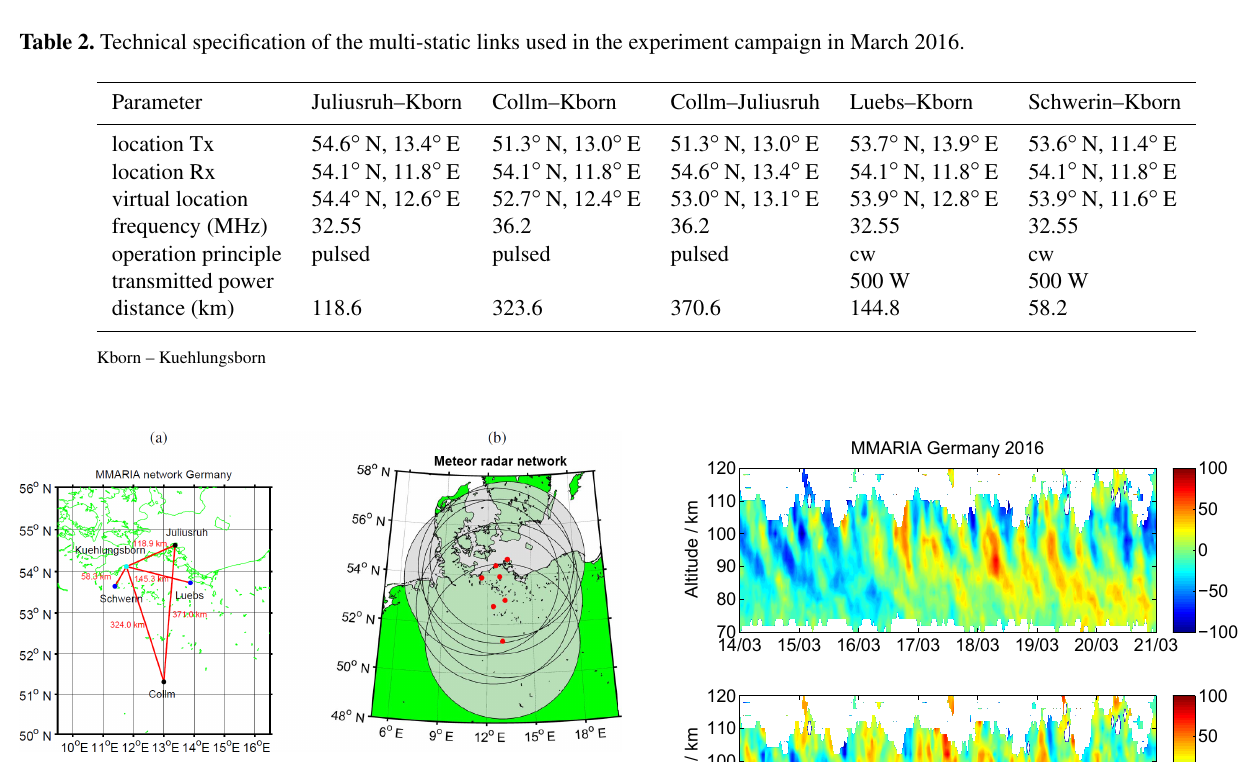
Figure 10. (a) Schematic view of multi-static network during the campaign in March 2016. (b) Geographic map of different viewing geometries (red points). The shaded areas label a circle of 300km in diameter around each center of radial velocity measurements.